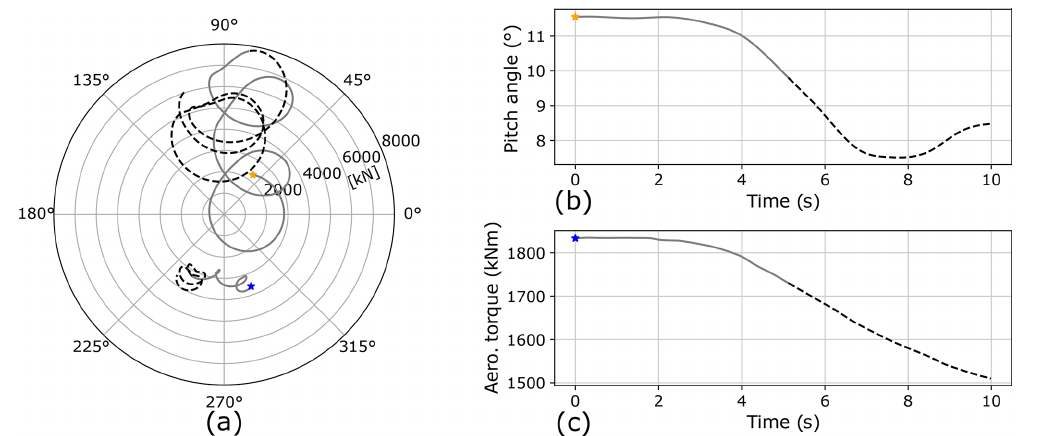
Figure 13. Radial main-bearing loads on the upwind row of the overhung support configuration, along with control variable values, resulting from extreme wind direction change events. Panel (a) shows radial loads during operation at 8ms − 1 (blue star) and 16ms − 1 (yellow star). Panels (b) and (c) show the concurrent control variable value at 16 and 8ms − 1 ,